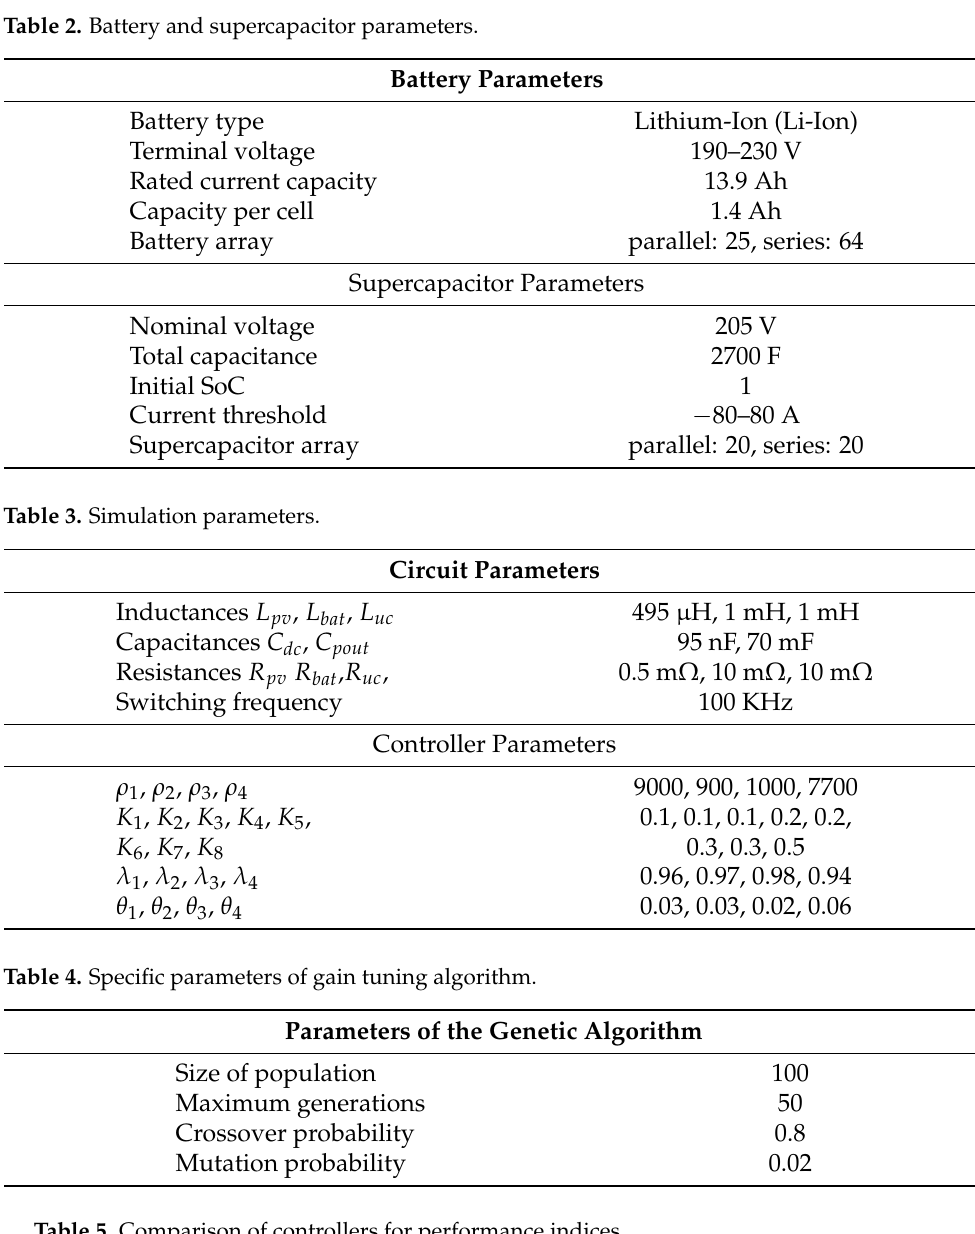
Table 5. Comparison of controllers for performance